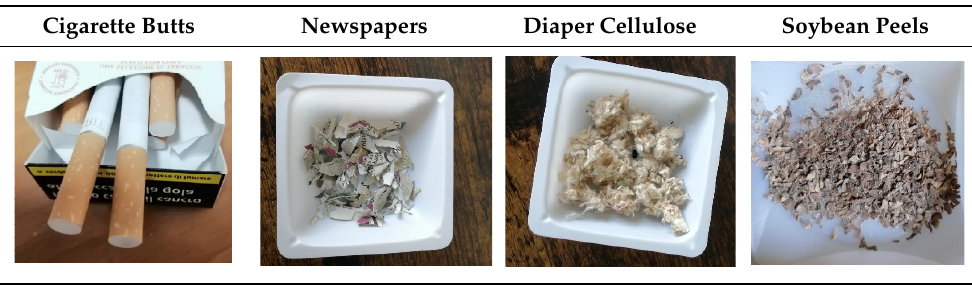
Table 2. Waste cellulosic matrices under investigation.